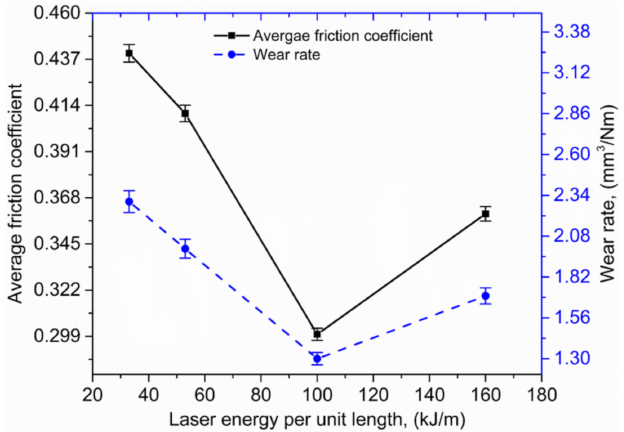
Figure 12. Friction coefficient and wear rate of TiC-reinforced Inconel 625 coated on a C45 carbon steel substrate; based on the data from [97].